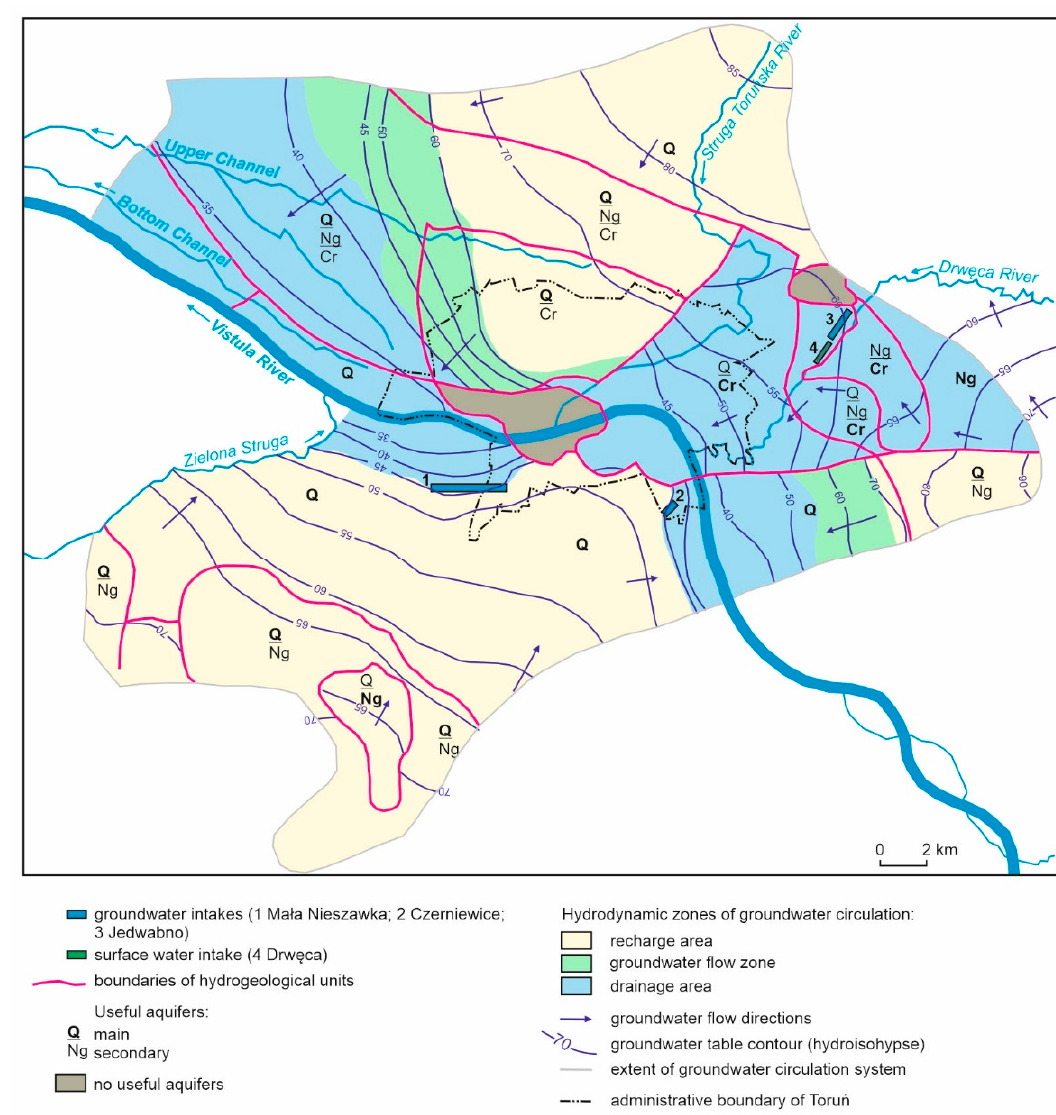
Figure 2. Hydrogeological map (own study based on [37]).